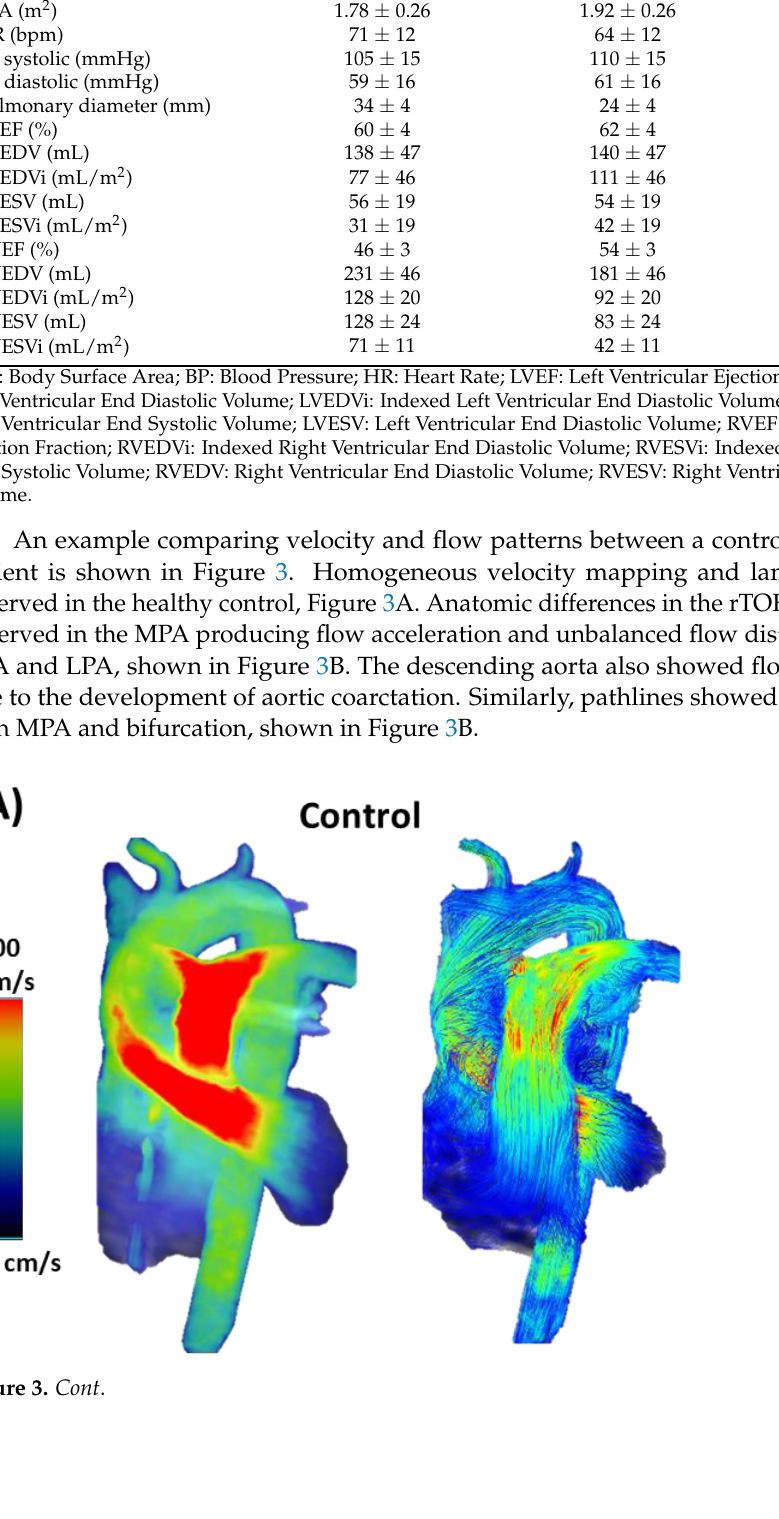
Figure 3. Comparison of velocity and flow patterns between a control and a patient with repaired Tetralogy of Fallow. Panel ( A ) shows homogeneous flow distribution in the velocity mapping (left) and laminar flow in the pulmonary artery and in the aorta (right). Panel ( B ) shows evidence of an- atomic anomalies in the main pulmonary artery and aortic arch. These anomalies produced flow acceleration, as pointed by the light grey arrow in the pulmonary artery and the orange arrow in the aorta. Helical flow was also observed along the pulmonary artery, as pointed out by the dark grey arrows. Figure 4 shows the 4D-flow assessment of total volume, peak velocity, and regurgi- tant fraction at the RVOT, pulmonary valve, MPA, RPA, and LPA. Total volume at the pulmonary valve was significantly elevated in the controls than in the rTOF (54 ± 18% vs. 74 ± 18%, p = 0.001, Figure 5A). In contrast, peak velocity and regurgitant fraction were significantly higher at all plane locations for the rTOF patients in comparison with the controls ( p < 0.001, Figure 5B,C).